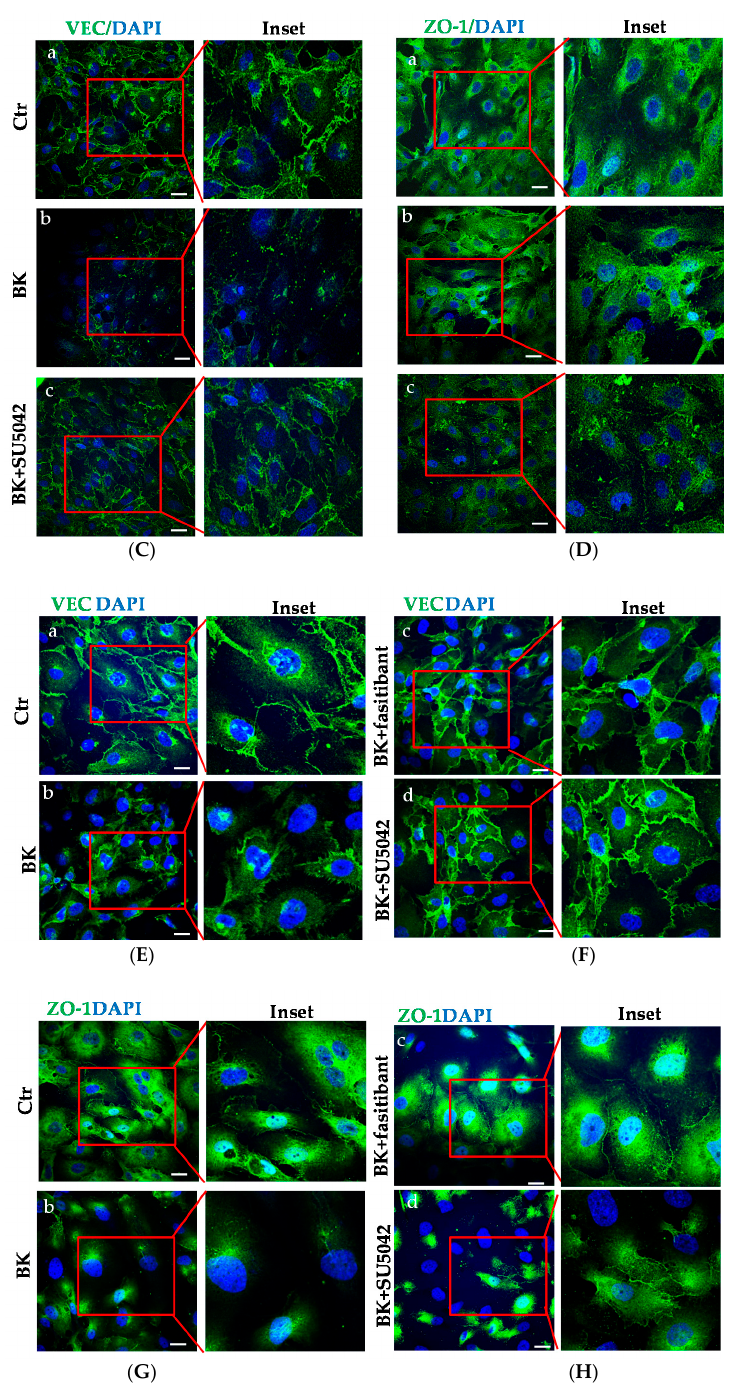
Figure 6. BK/B2R system promotes changes of permeability, endothelial junctions and migration via FGFR-1. ( A ) Permeability in HUVEC and ( B ) HREC monolayers were detected as a passage of fluorescence-conjugated FITC-Dextran from upper to lower compartments (numbers represent mean 6 ± SEM of three experiments run in triplicate; n = 3). Fasitibant (1 µ M) and SU5402 (1 µ M) prevent the enhanced permeability, *** p < 0.001 vs. Ctr cells, ## p < 0.01 ### p < 0.001 vs. BK-treated cells. ( C , D ) Confocal analysis of VEC and ZO-1 expression (magnification 63 × ) evaluated by immunofluorescence analysis in HUVEC treated with 0.1% FBS in panel a, BK (1 µ M) in panel b, and SU5402 + BK in panel c. ( E , F ) Confocal analysis of VEC and ( G , H ) ZO-1 expression (magnification 63 × ) evaluated by immunofluorescence analysis in HREC treated with 0.1% FBS in panel a, BK (1 µ M) in panel b, BK + fasitibant (10 µ M) in panel c, and SU5402 + BK in panel d. Bar = 20 µ m. VEC and ZO-1 were stained in green and DAPI (blue) was used to counterstain the nuclei. Boxed areas are shown in detail in the